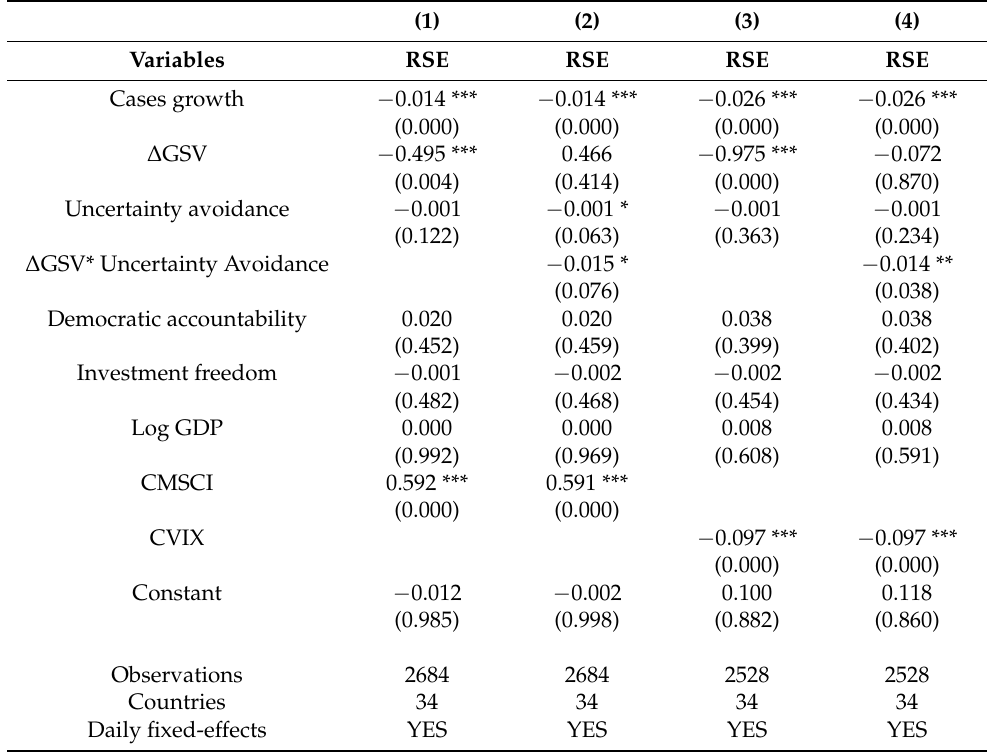
Table A3. Panel regression results: robustness tests with additional